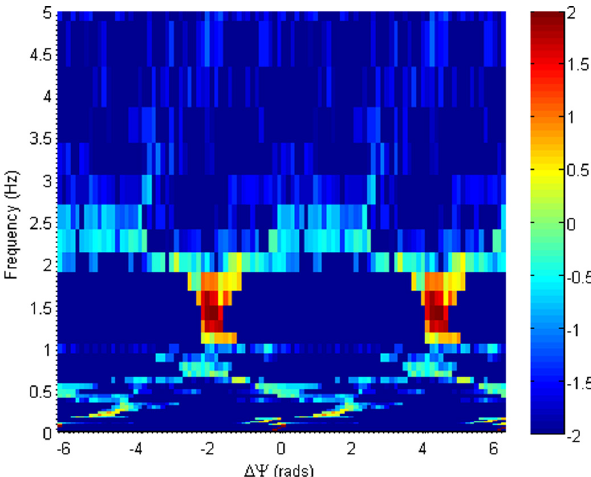
Fig. 4. The joint frequency– 1ψ spectrum of the B y component of the magnetic field, for the same wave packets as pictured in Fig. 3. The colour bar is in arbitrary units representative of the relative power spectral density as a function of frequency and phase differ- ence. The periodicity of the spectrum corresponds to an ambiguity of 2 πn in the phase difference.